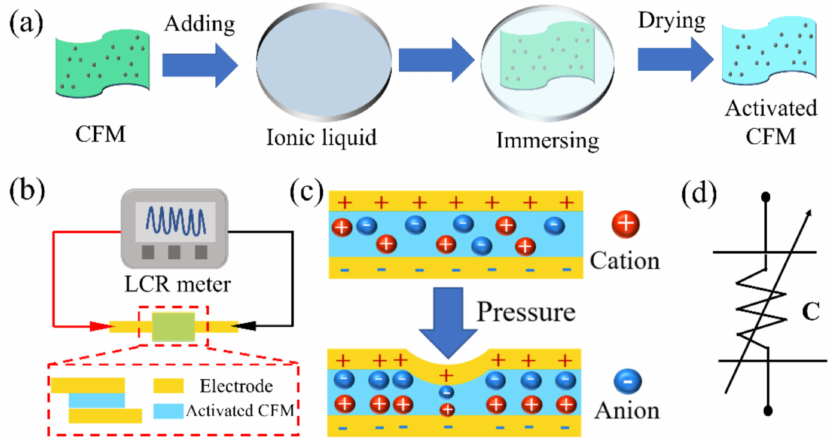
Figure 3. ( a ) Fabrication of the dielectric layer of the ionic liquid-based CFM, ( b ) schematic of the pressure sensor structure and its sensing system, ( c ) schematic illustration of the sensing principle, and ( d ) equivalent sensing of the pressure